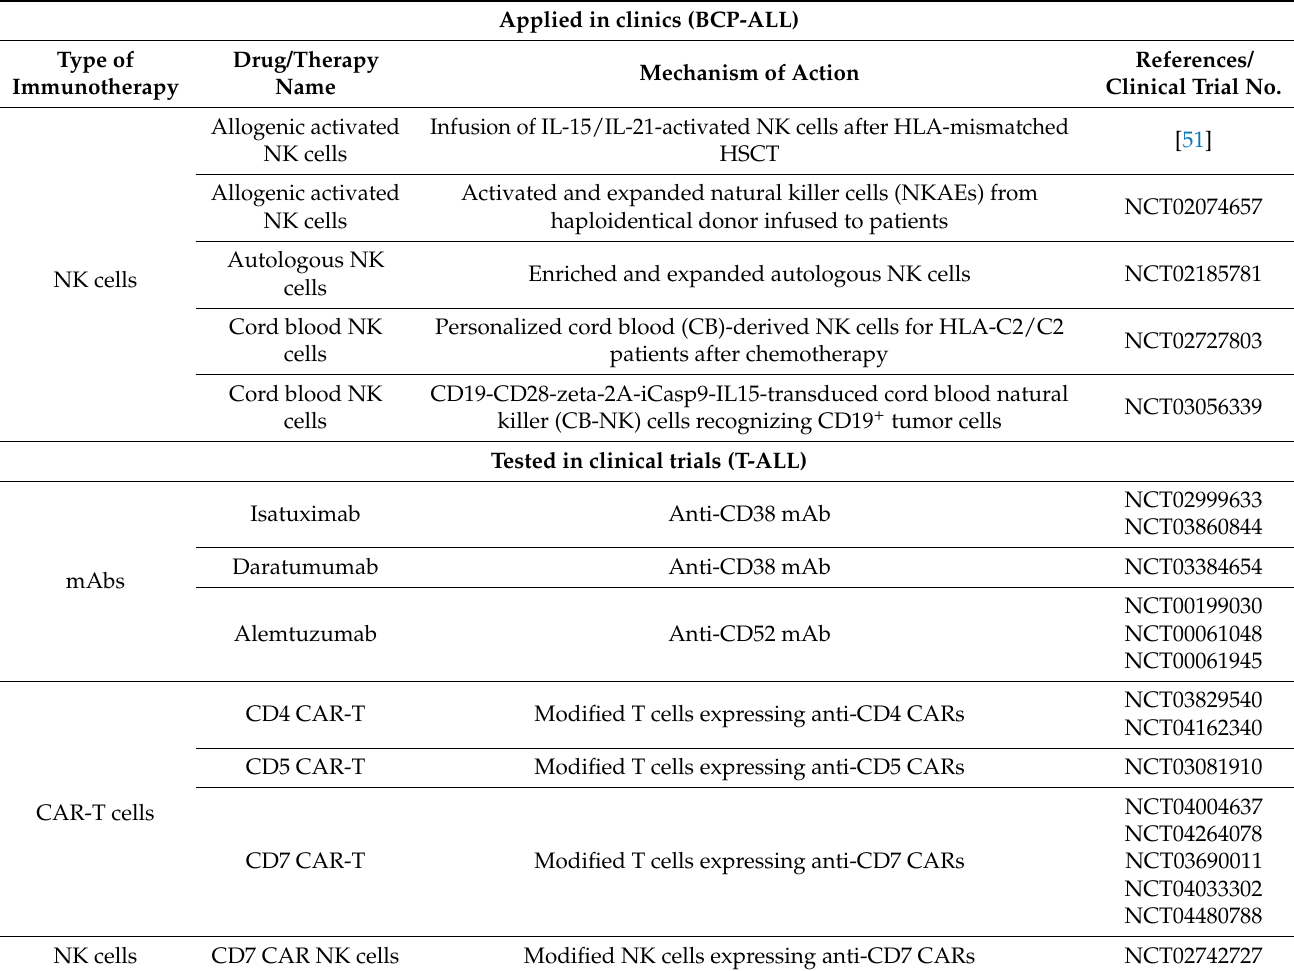
Table 3. Cont. Applied in clinics